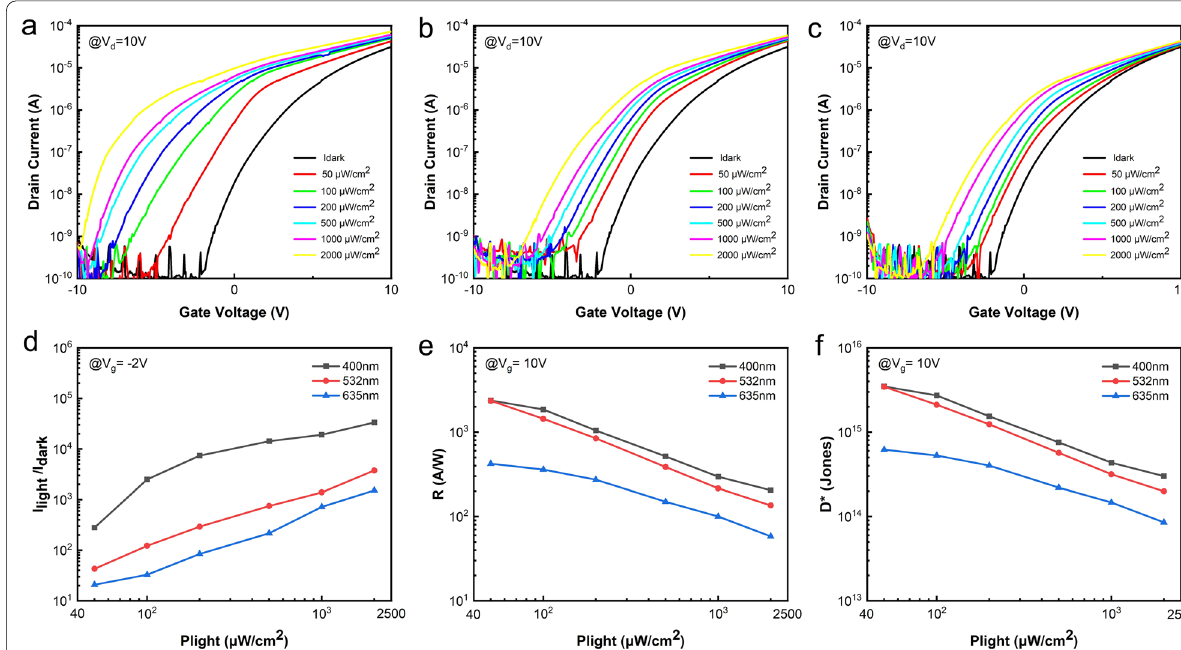
Fig. 2 a – c Transfer curves of as‑fabricated synaptic transistor measured in dark and under illumination by monochromatic light at different wavelengths ranging from 400 to 635 nm. d The I light / I dark ratio measured at V d as‑fabricated synaptic transistor as functions of the incident light power intensity, measured at V d